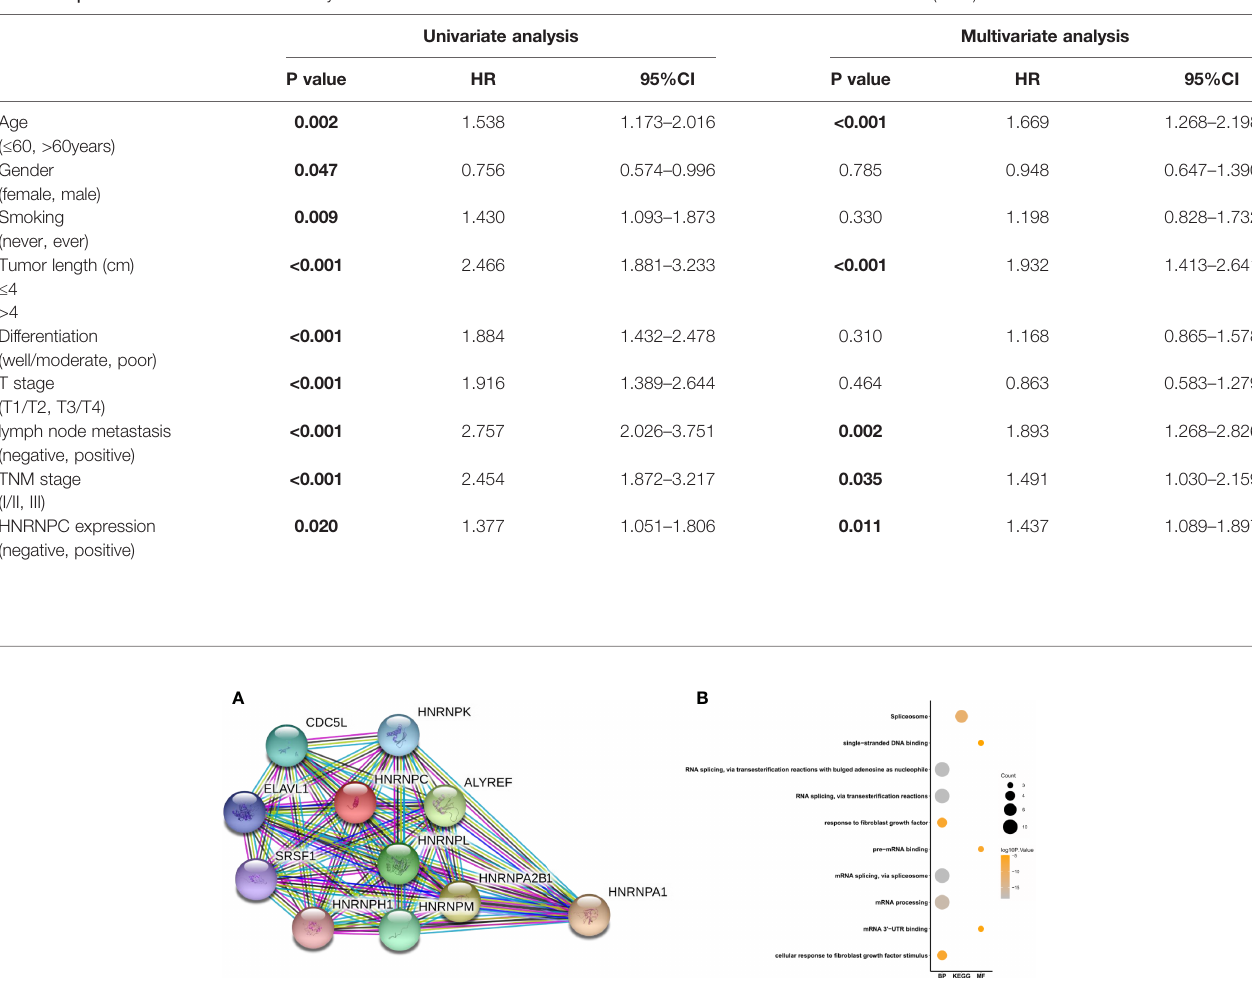
TABLE 4 | Univariate and multivariable analysis of factors associated with overall survival in National Cancer Center of China (NCC) cohort.